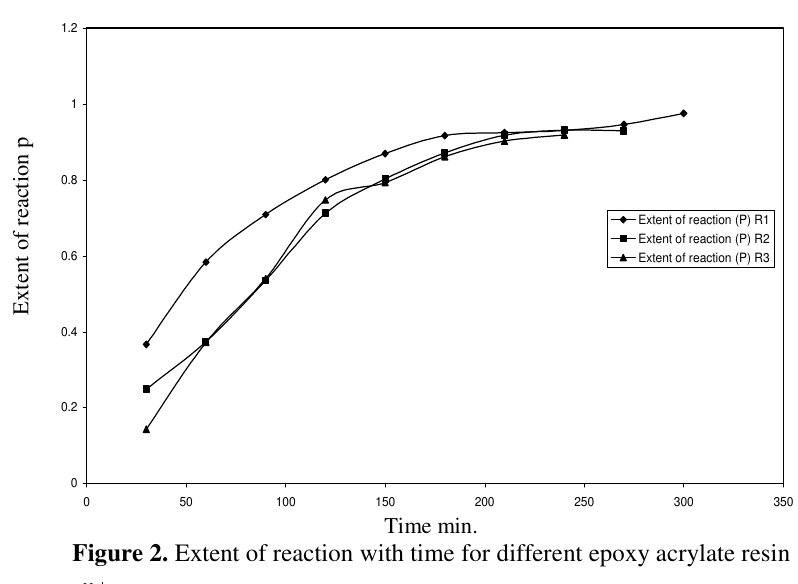
Figure 2. Extent of reaction with time for different epoxy acrylate resin